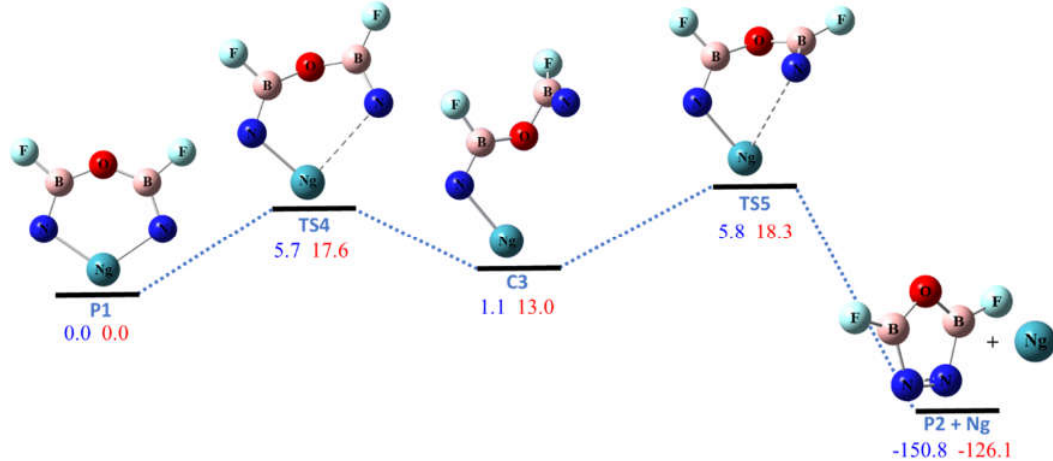
The potential energy (in kcal/mol) profile for the dissociation of NgON 2 B 2 F 2 (Ng = Kr, Xe) at